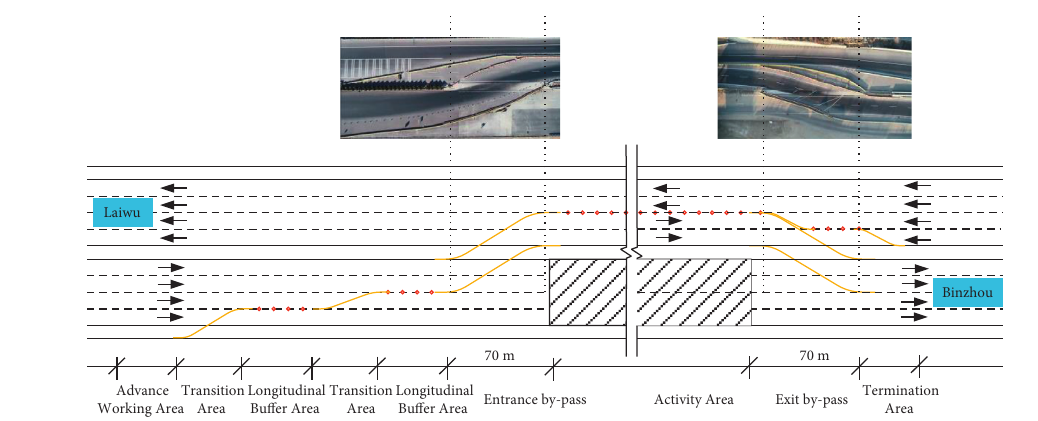
Figure 10: Hovering drone photography area and data extraction range. Table 6: Relative difference between driving simulation and actual